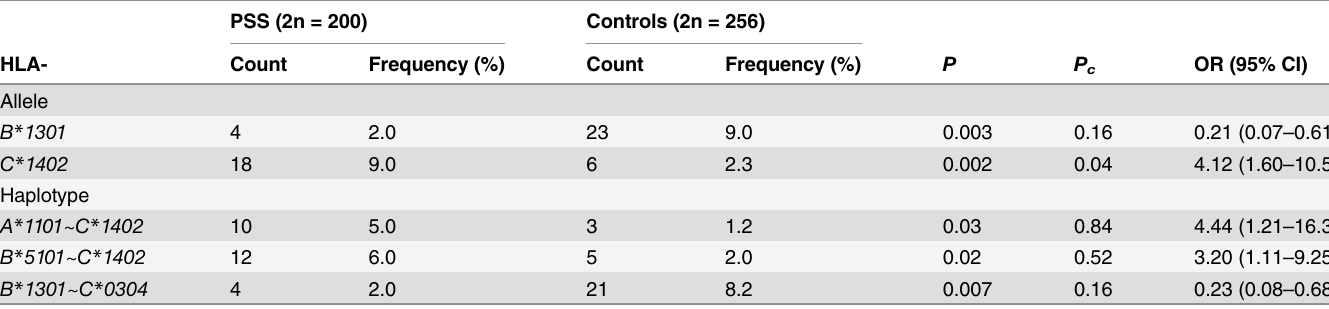
Table 4. Significant alleles and haplotypes associated with